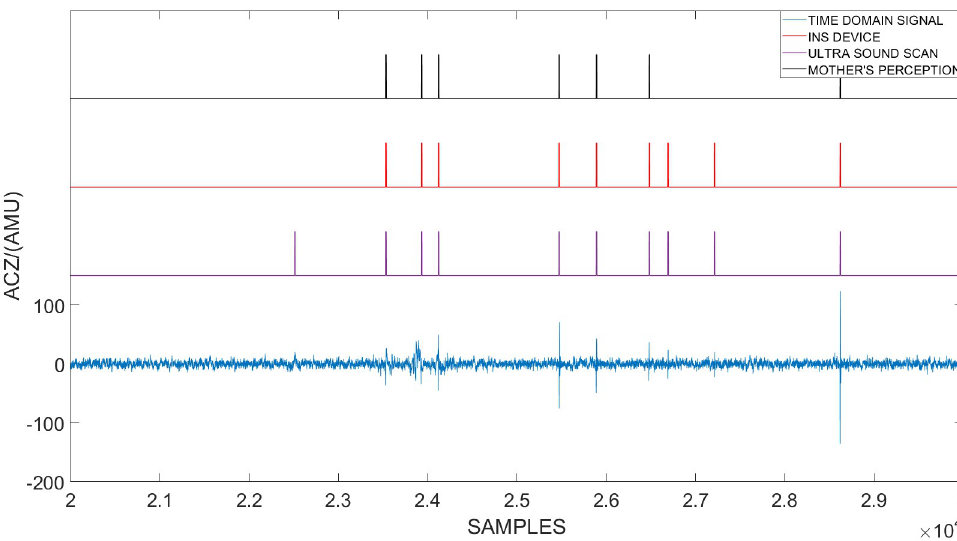
Fig 5. The time-domain signal of a singleton pregnancy observed by the sensor and the fetal movement identified by each method. In this figure the time domain accelerometric data along the Z-Axis recorded during a single session is plotted against the sample number. This session was conducted on a pregnant mother with a singleton pregnancy. During the session three methods were utilized to identify the occurrence of a fetal movement. They are: An abdominal Ultrasound scan, mother’s perception and the in-house fabricated device. The instances where each method identified the occurrence of a fetal movement are indicated by